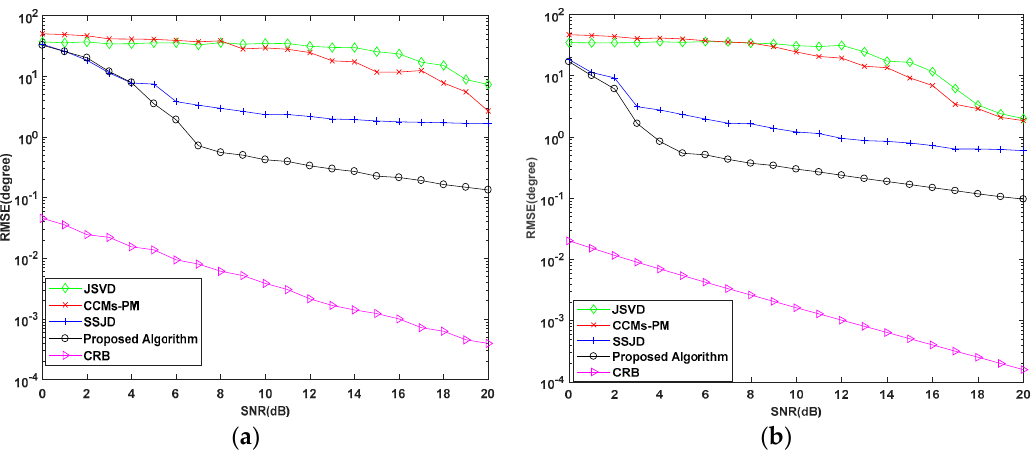
Figure 10. RMSE performance versus SNR for a small number of snapshots with ( a ) snapshots = 10; ( b ) snapshots = 20.